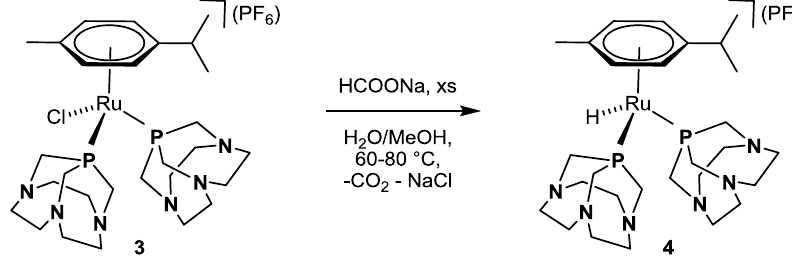
Scheme 2. Conversion of 3 to 4 by reaction with HCOONa in H 2 O/MeOH.